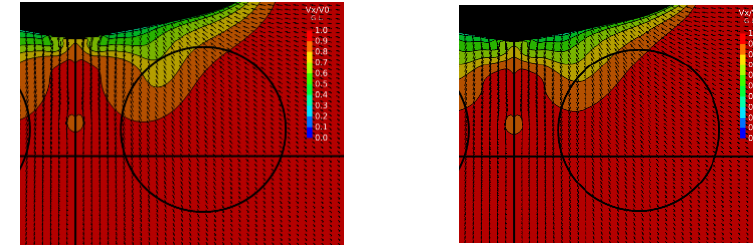
Figure 16. Comparison of results of the wake distribution of Model5415. ( Left : EFD, Center : k - omega SST, Right : LPST) .